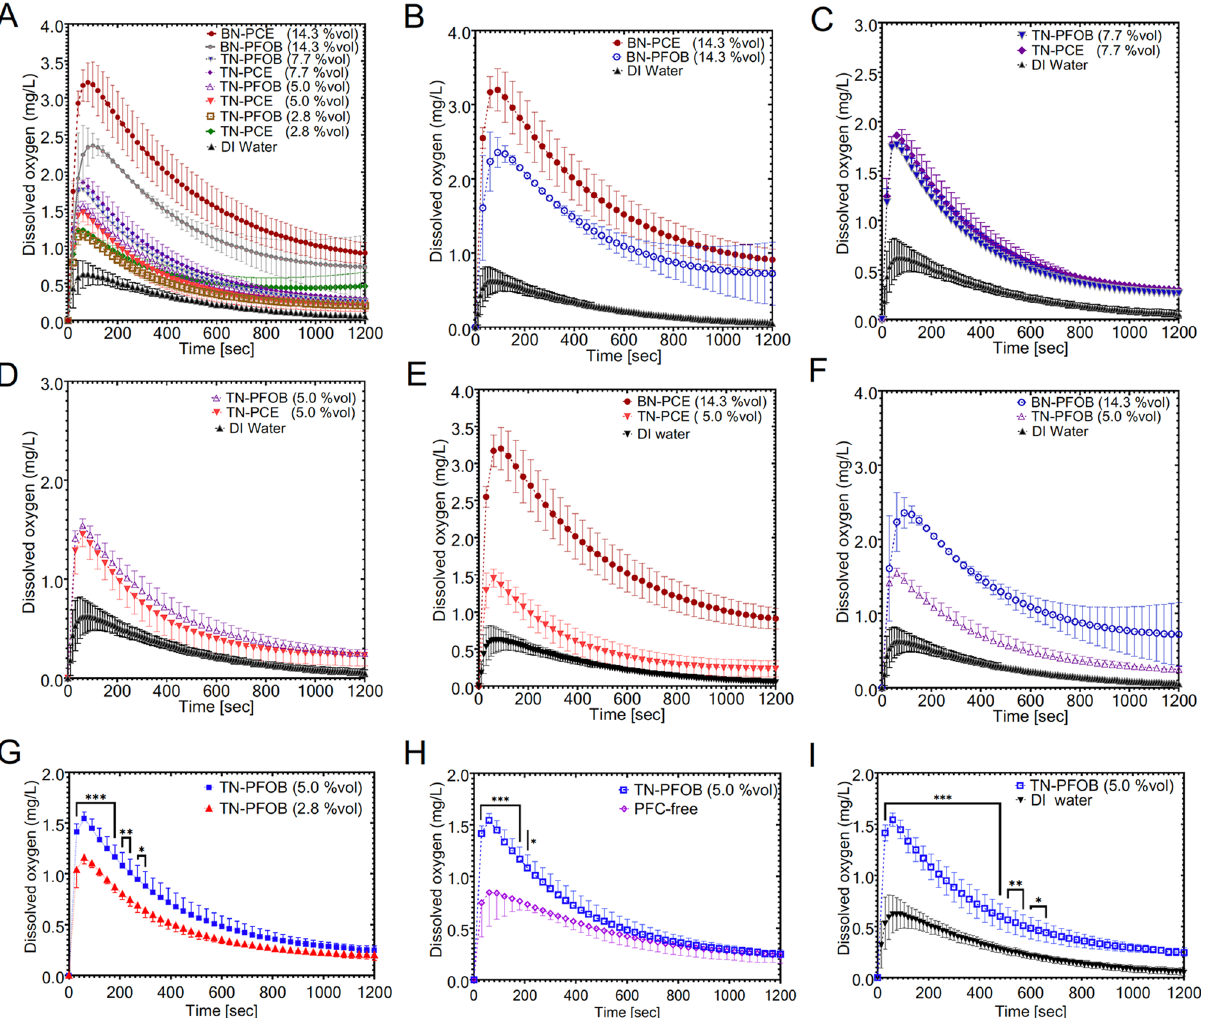
Figure 4. Dissolved oxygen vs. time profiles in in vitro oxygen release experiments for select samples. In each release profile, a maximum dissolved oxygen concentration (C max ) was extracted and used as the metric by which different samples were compared. ( A ) Release profiles compiled for formulations ranging from 0 to 14.3 vol% PFC. ( B ) Comparison of BNs composed of different PFC types, both at the highest level of PFC. ( C , D ) Comparison of 2 TNs composed of different PFC types at identical PFC levels. ( E , F ) comparison of BNs and TNs of the same PFC type. ( G ) Comparison of TN-PFOB of different internal phase volume fractions. ( H , I ) Comparison of TN-PFOB to biphasic hydrocarbon nanoemulsion and DI water control. Where standard error bars are shown, each point is mean of three measurements ± SD. Asterisks label time points or intervals